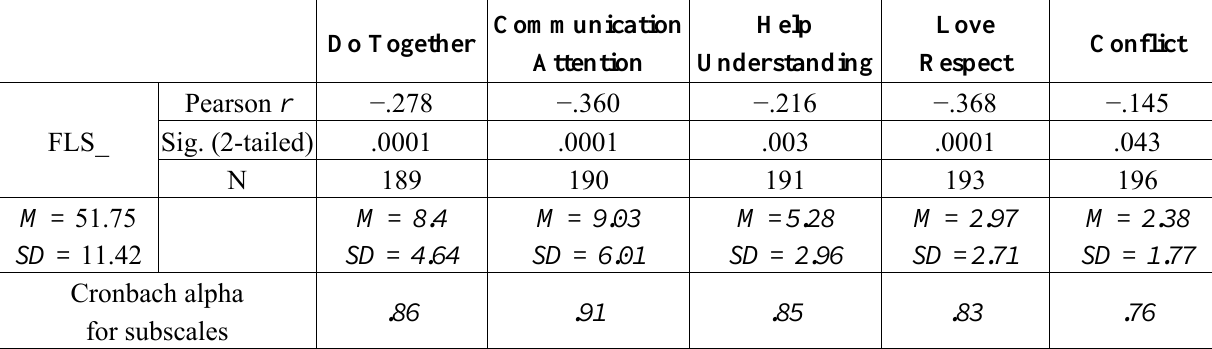
Table 3. Subscale alphas and correlations with Family Life Survey